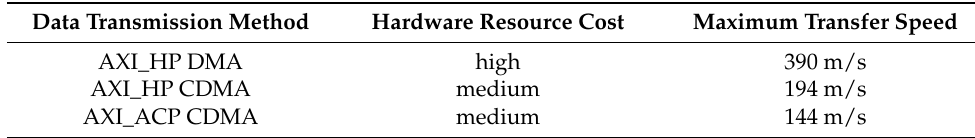
Table 3. Comparison of different data transmission